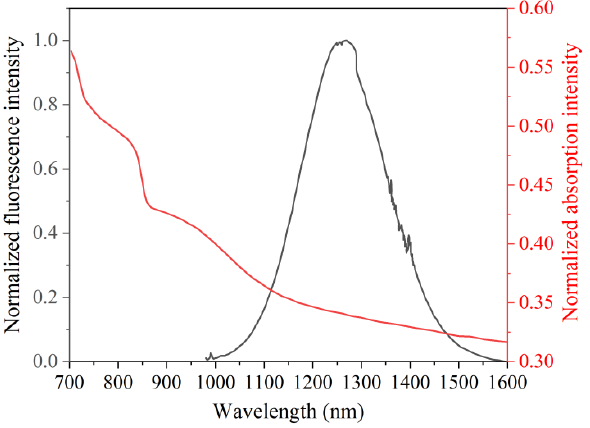
Figure 2. Absorption and fluorescence spectra from PbSe QD-doped glass fiber.